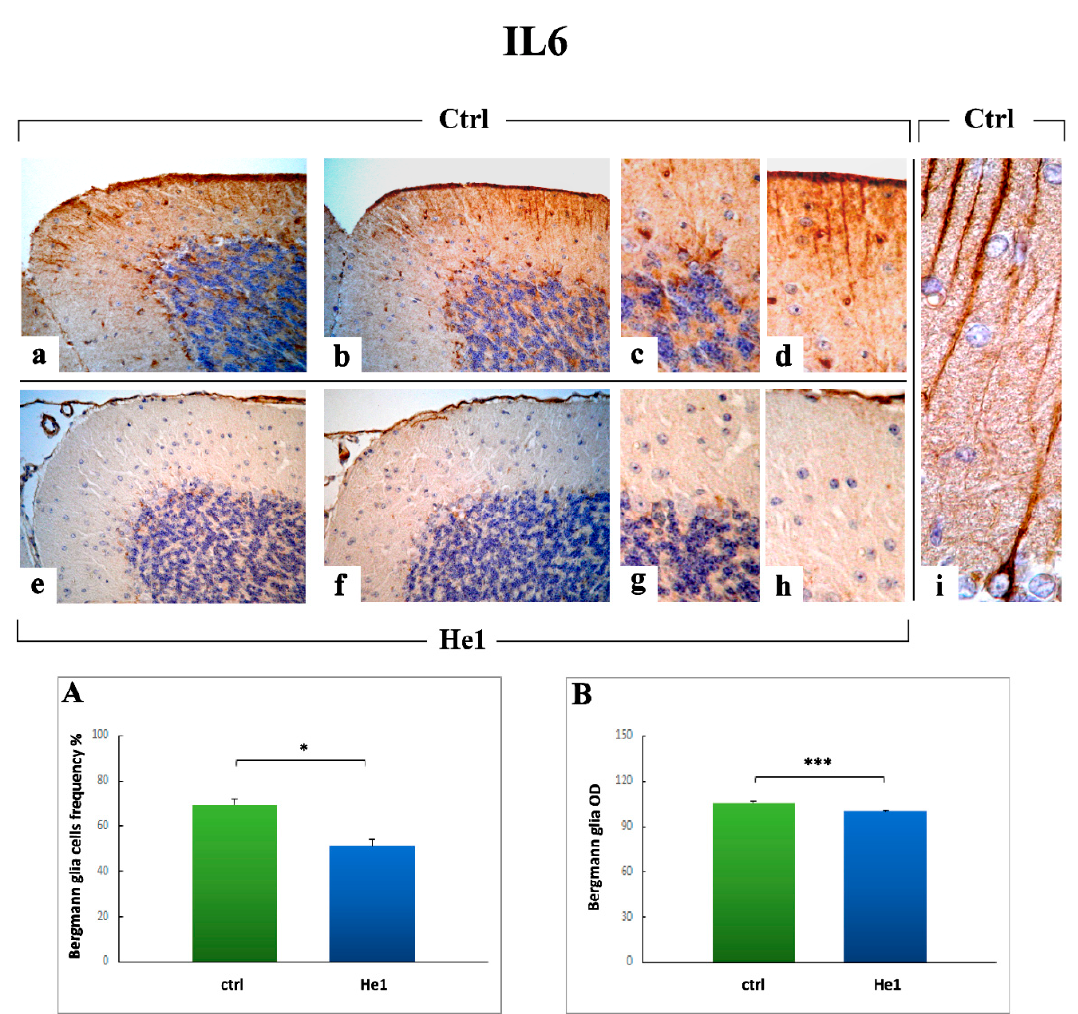
Figure 7. IL6 DAB-immunostaining reaction in untreated ( a – d , i ) and He1-treated mice ( e – h ). Light microscopy magnification: 40× ( a , b , e , f ); 100× ( c , d , g , h ). Panels ( A , B ) Histograms showing immunopositive BG cells frequency and OD, respectively. p values calculated by unpaired Student’s t -test: * p < 0.05, *** p < 0.001.